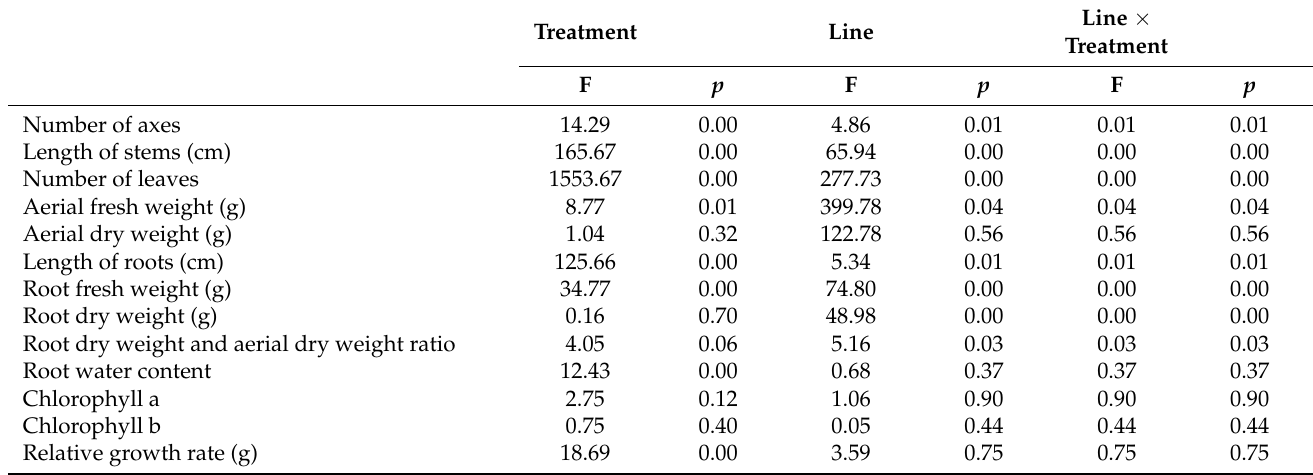
Table 1. Effects of lines, water deficit treatments, and the interaction of line × treatment on measured traits for the studied lines of M. truncatula under control condition and 30% of field capacity (FC).